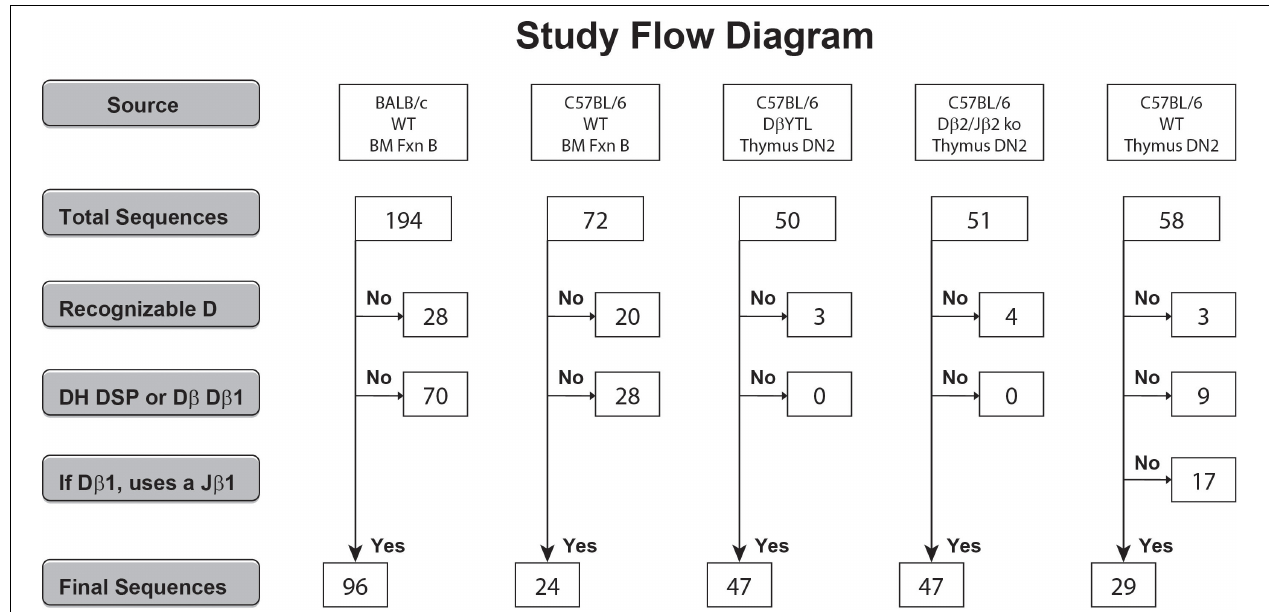
FIGURE 1 | Flow diagram of the derivation and the numbers of the DSP- and D β 1-containing CDR3 sequences analyzed. Sequences that did not meet individual criteria were discarded into the “No” pool. Sequences that met all the individual criteria were pooled into the “Yes” pool.